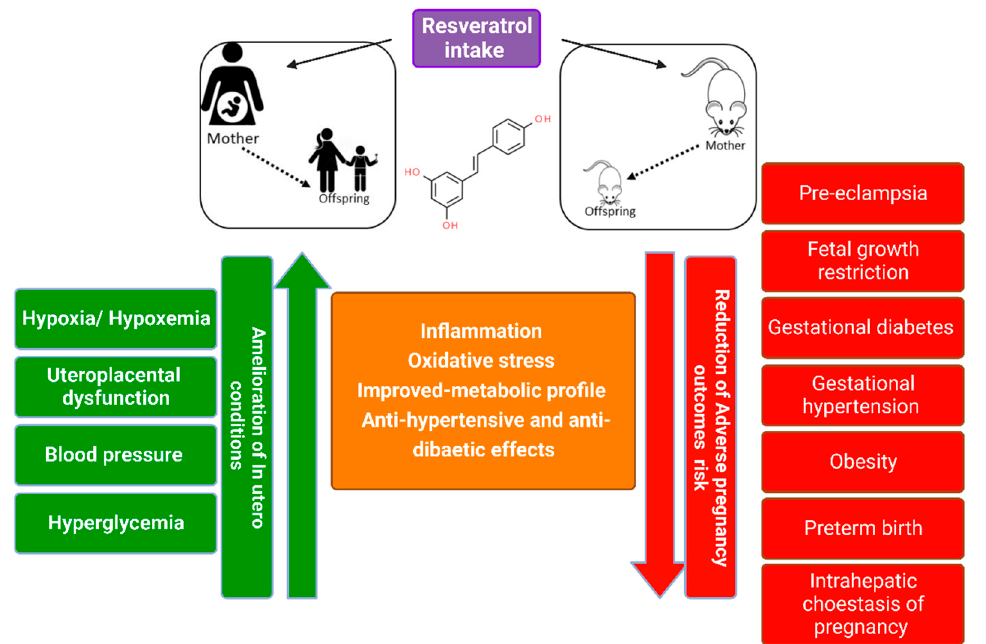
Figure 2. Maternal resveratrol supplementation decreases the risk of adverse pregnancy outcomes by ameliorating the in-utero conditions. Schematic representation of the resveratrol-impacted crosstalk between abnormal in-utero conditions and adverse pregnancy risk.